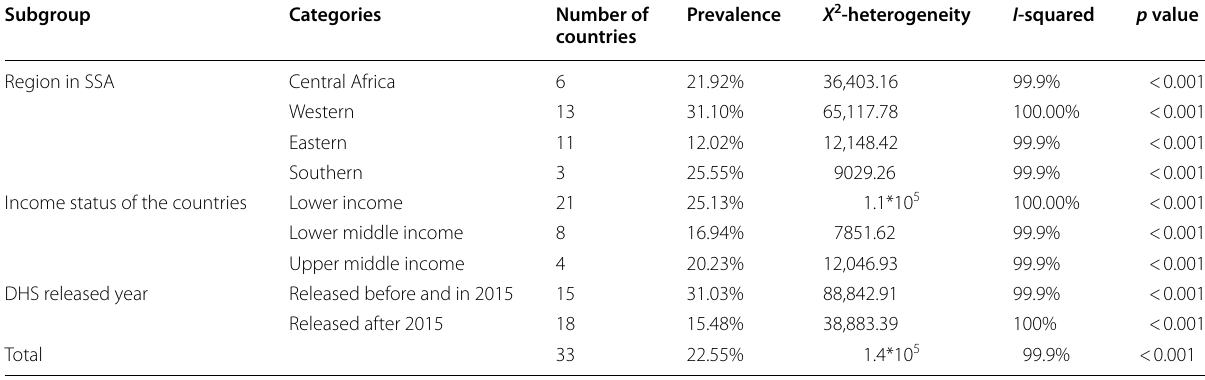
Table 4 Subgroup analyses of open defecation among households in SSA